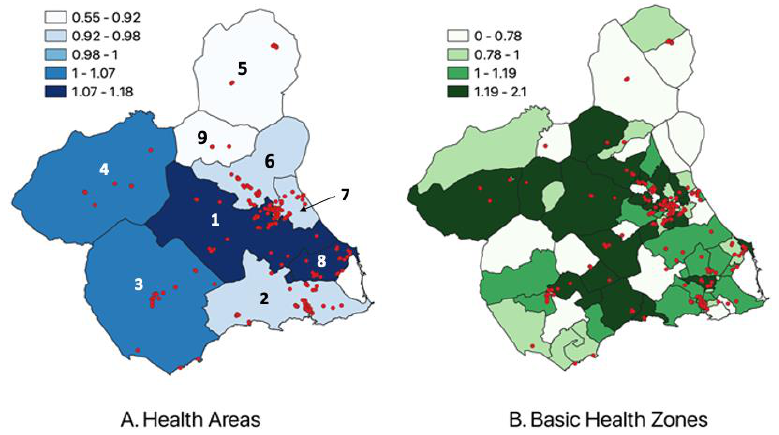
Figure 4. SIR by health areas and basic health zones in the region of Murcia, 1998–2020 (n = 822).